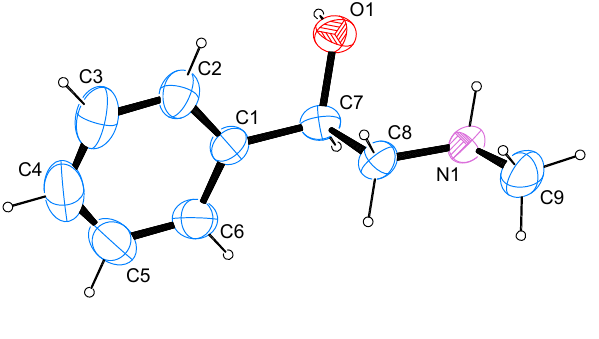
Table  : Data collection and handling.